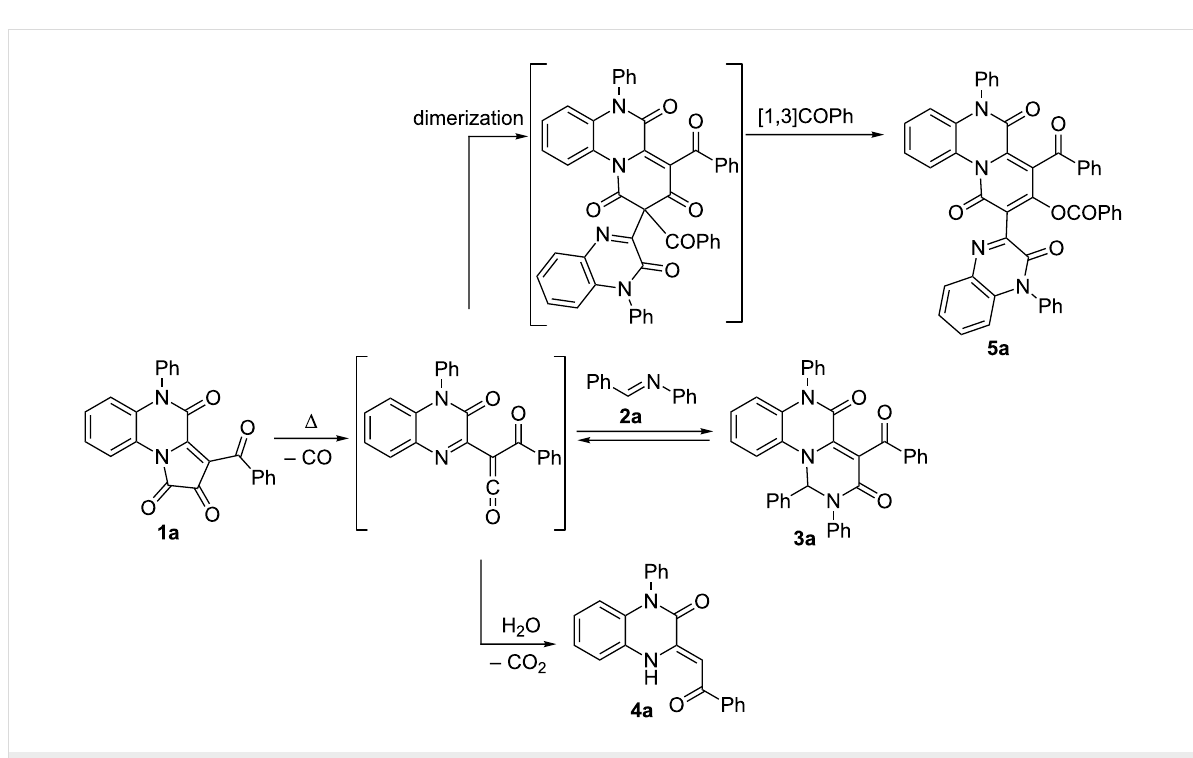
Scheme 2: Side-reactions concurring with intermolecular trapping of ketene generated from PQT 1a by benzalaniline ( 2a